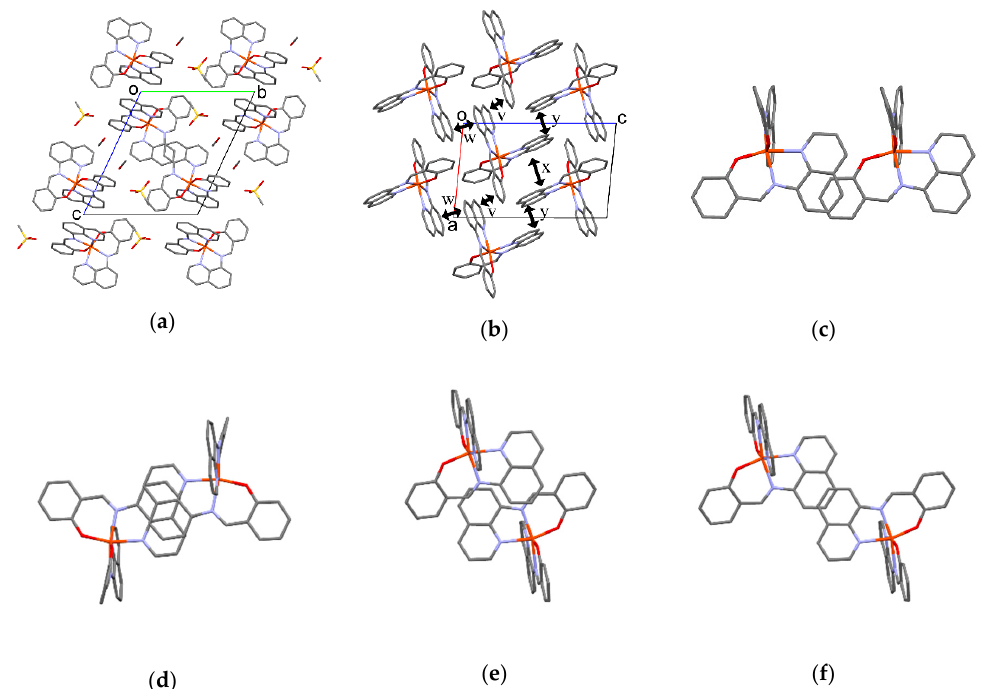
Figure 9. ( a ) Crystal structure viewed along the a axis of 3 at 293 K; ( b ) Side view of the π -stacking structure of 3 ; Top views of the π -stacking structure for v ( c ), w ( d ), x ( e ), and y ( f ). Hydrogen atoms are omitted for clarity. Table 8. Selected intermolecular distances (Å) in 3 Position a